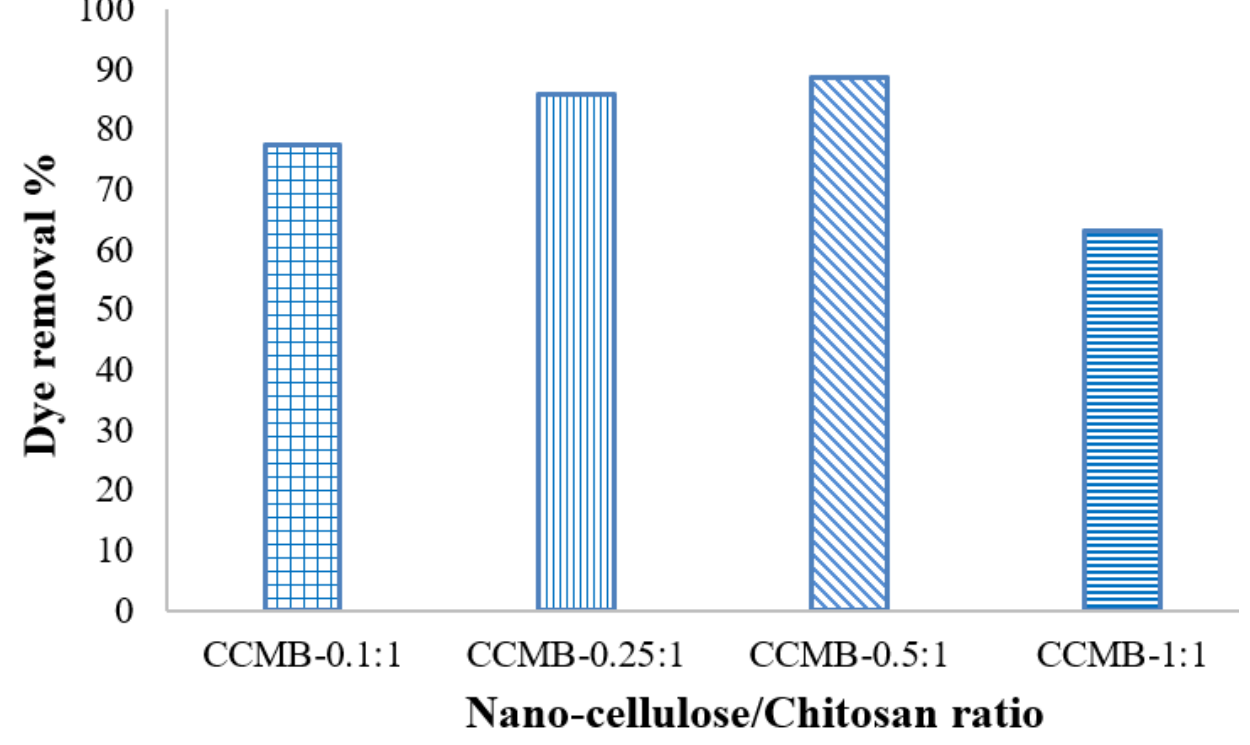
Figure 18. Effect of nanocellulose concentration in microbeads on removal efficiency.